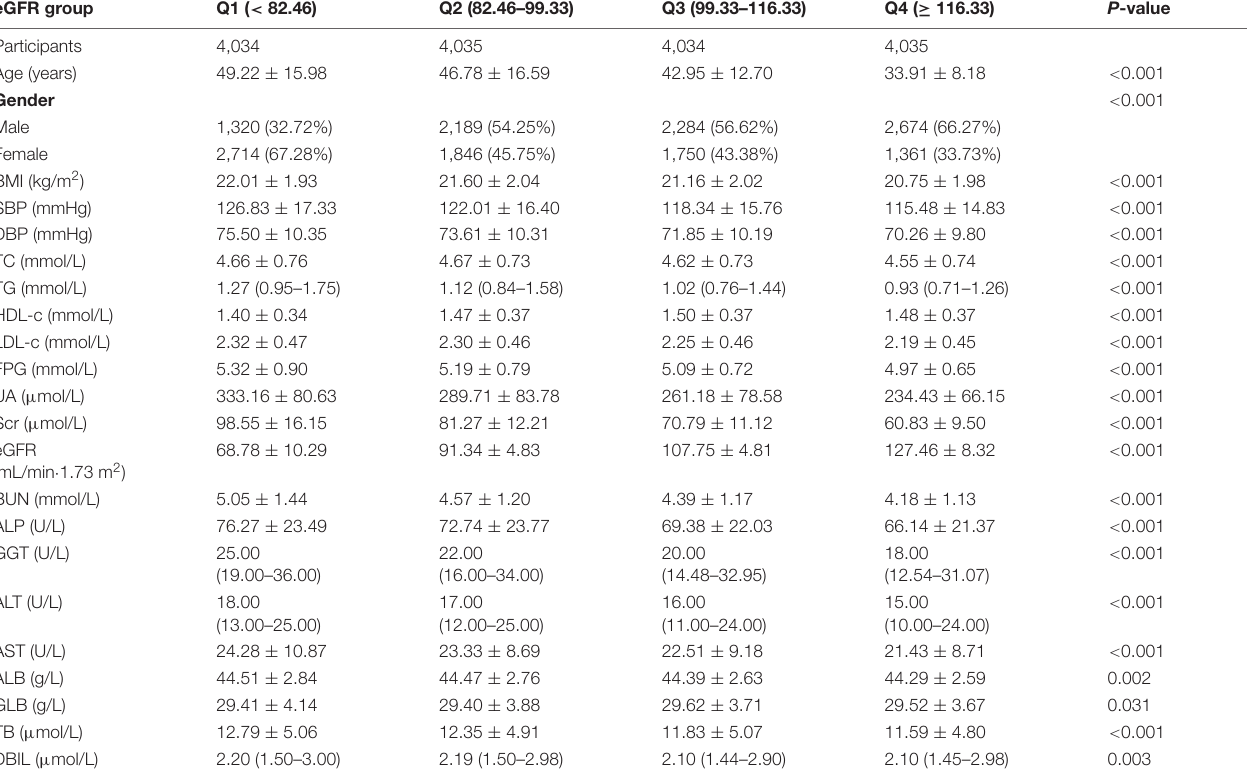
TABLE 1 | The baseline characteristics of participants.